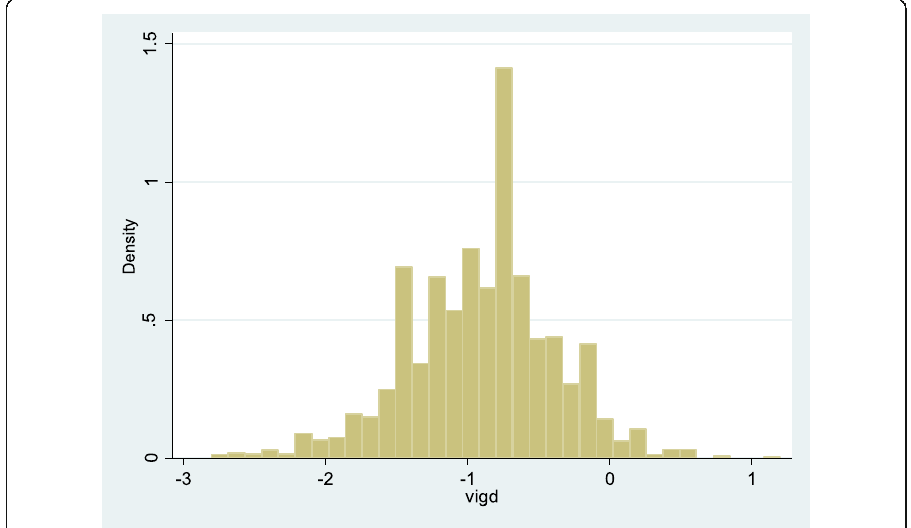
Fig. 9 Distribution of individual reporting heterogeneity from vignette set D. Note: Health domains in set A includes cognition and